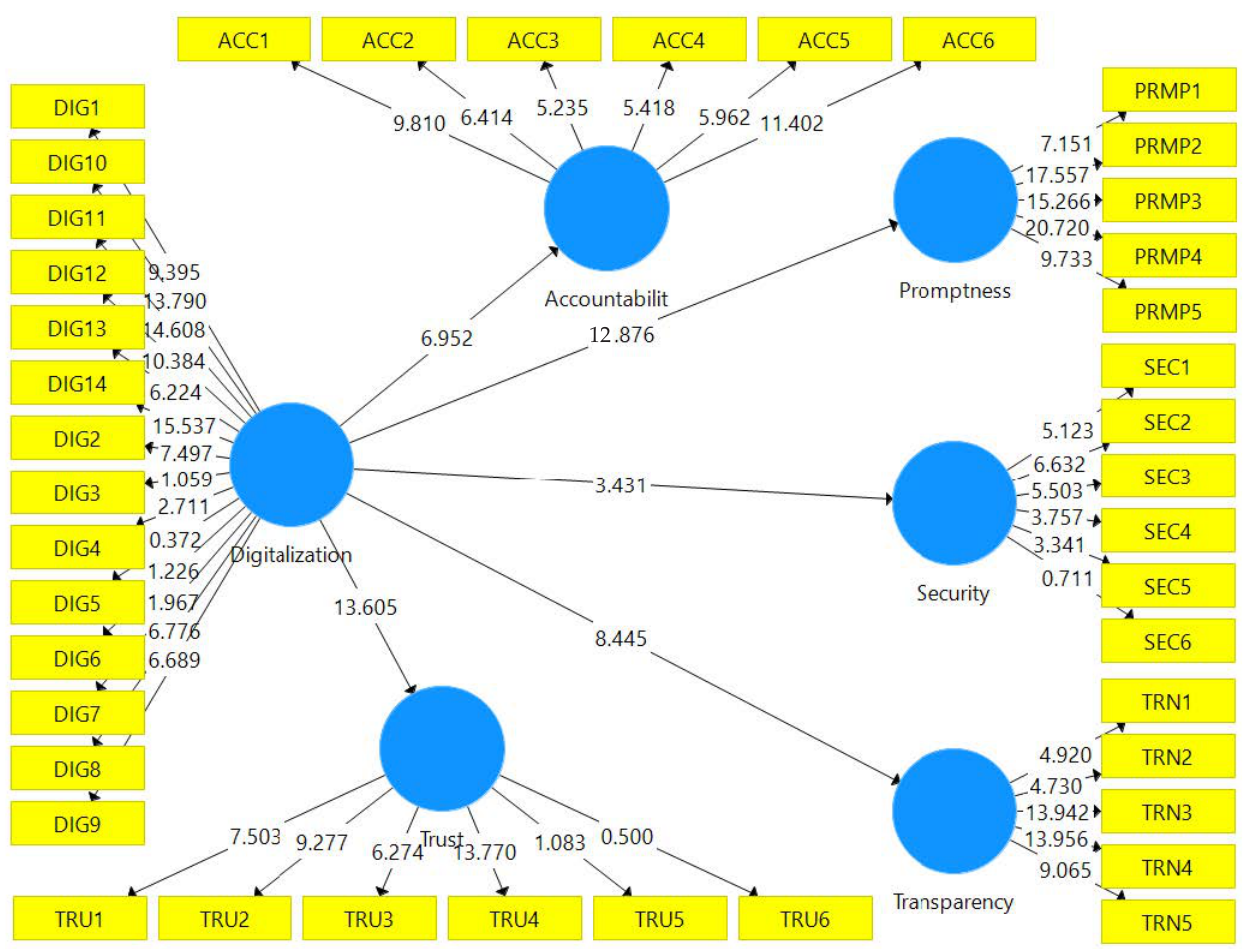
Figure 5. T-Statistic Values. Note: DIG = Digitalization, ACC = Accountability, SEC = Security, TRU = Trust, TRN = Transparency, PRMP = Promptness